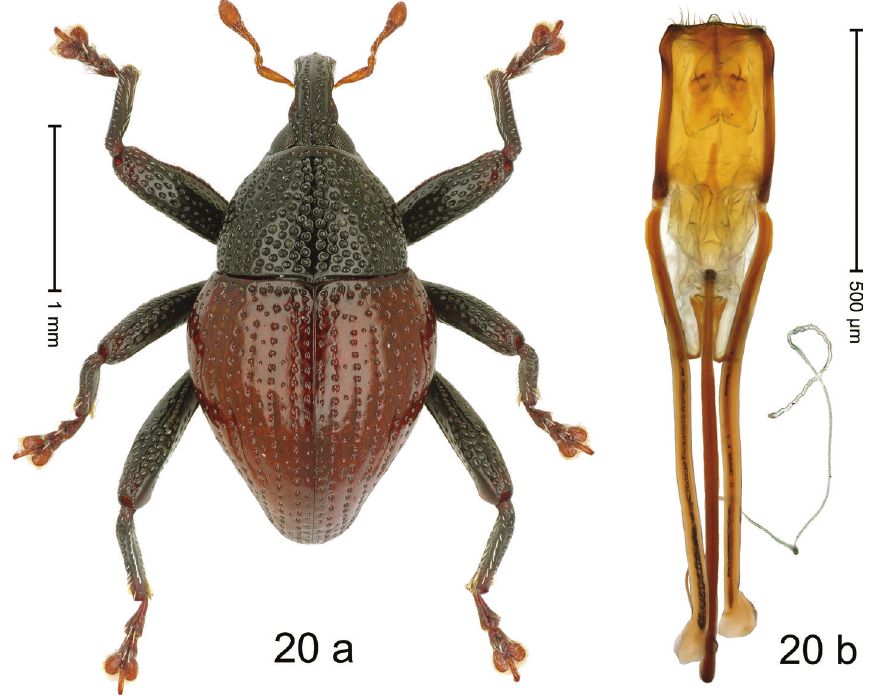
Figure 20. Trigonopterus rubidus sp. nov., holotype a habitus b penis.